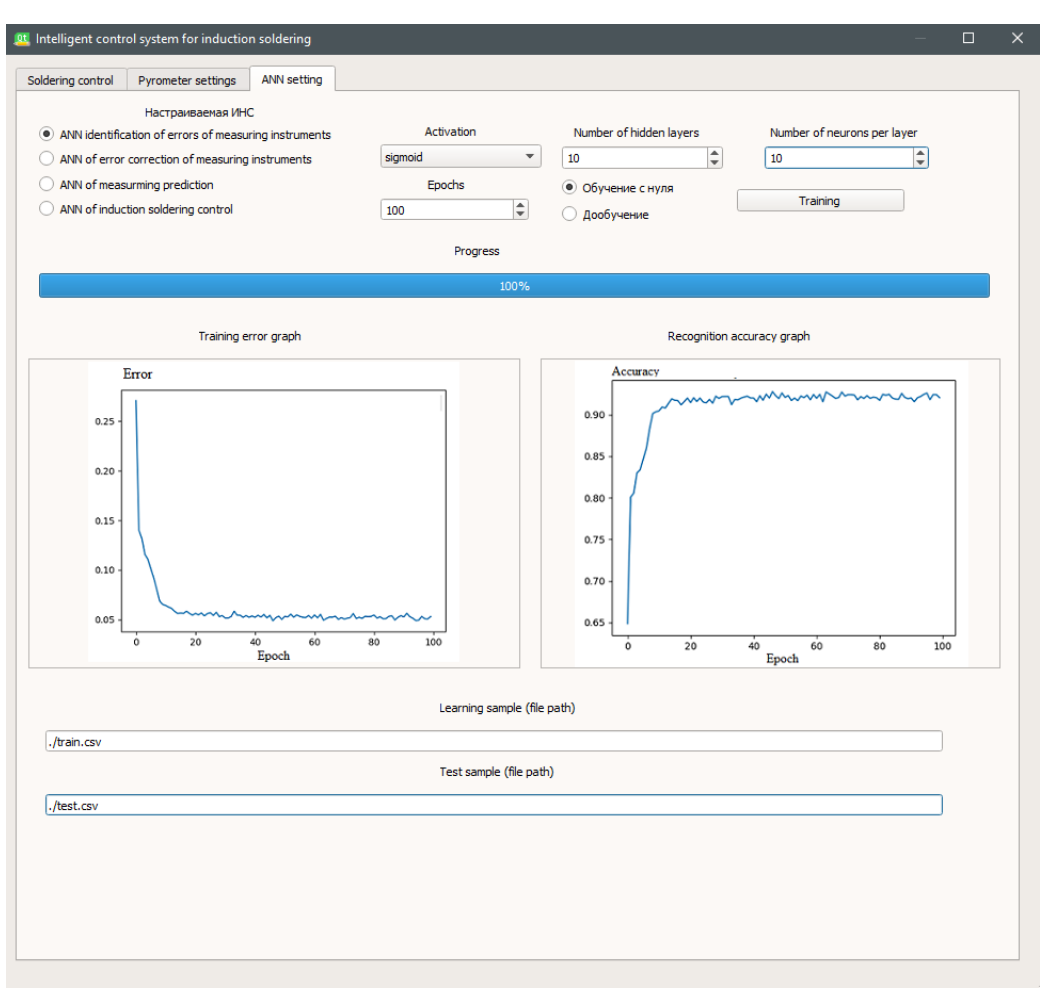
Figure 18. Artificial neural networks settings tab.